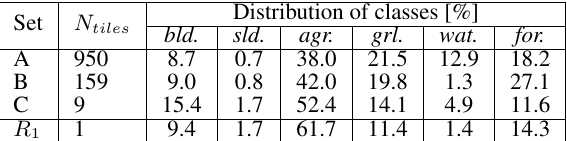
Table 1. Number of tiles ( N tiles ) of the different training